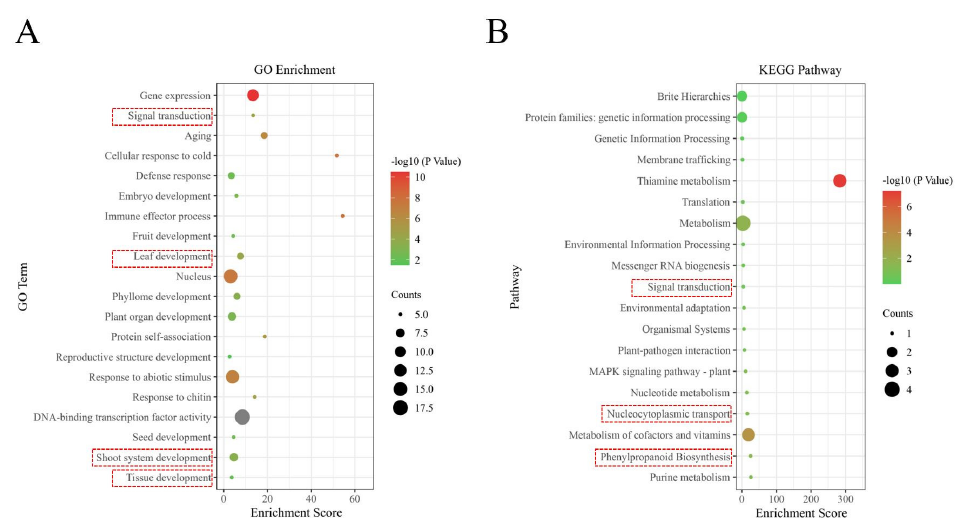
Figure 5. The GO terms ( A ) and KEGG pathways ( B ) enriched of LiNAC genes. The black circles indicate the number of target genes and different colors indicate the p − value.